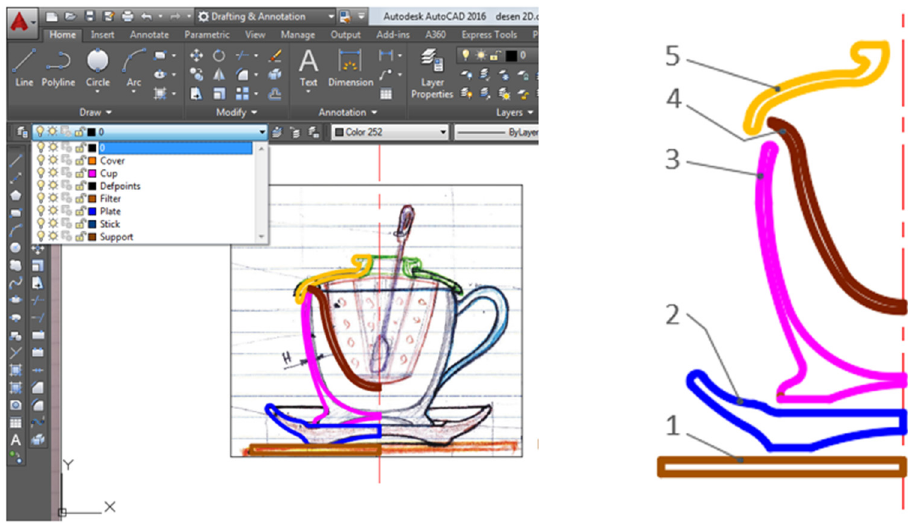
Figure 5. Redesign on different layers of section profiles in the AutoCAD environment: children’s toy set—teacup: (1) promo biscuit holder, (2) saucer, (3) teacup, (4) separator filter, (5) lid.